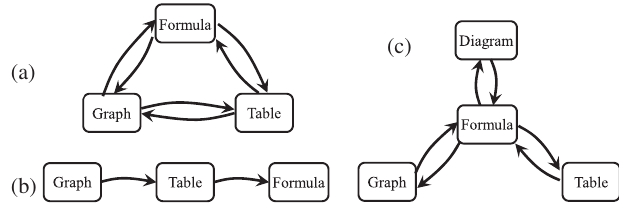
FIG. 12. Hypothetical examples of (a) an all-register synergy; (b) a semiotic chain; (c) a synergy of registers with missing transitions and a central base representation (Formula). A formula can be any algebraic expression, and a diagram could be a free body diagram or a phase diagram, for